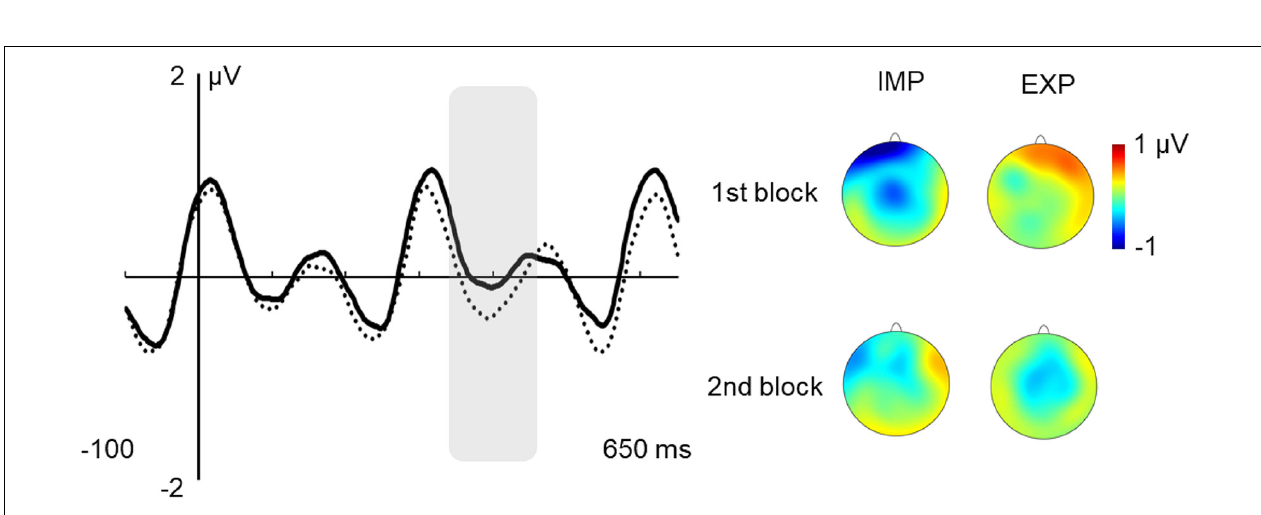
FIGURE 5 | Effect of type of “word” in the N400 Time Window. Note: effect of type of “word” in the N400 time window at the central ROI (solid line: hard; dotted line: easy) and voltage maps of the difference between easy and hard “words.”